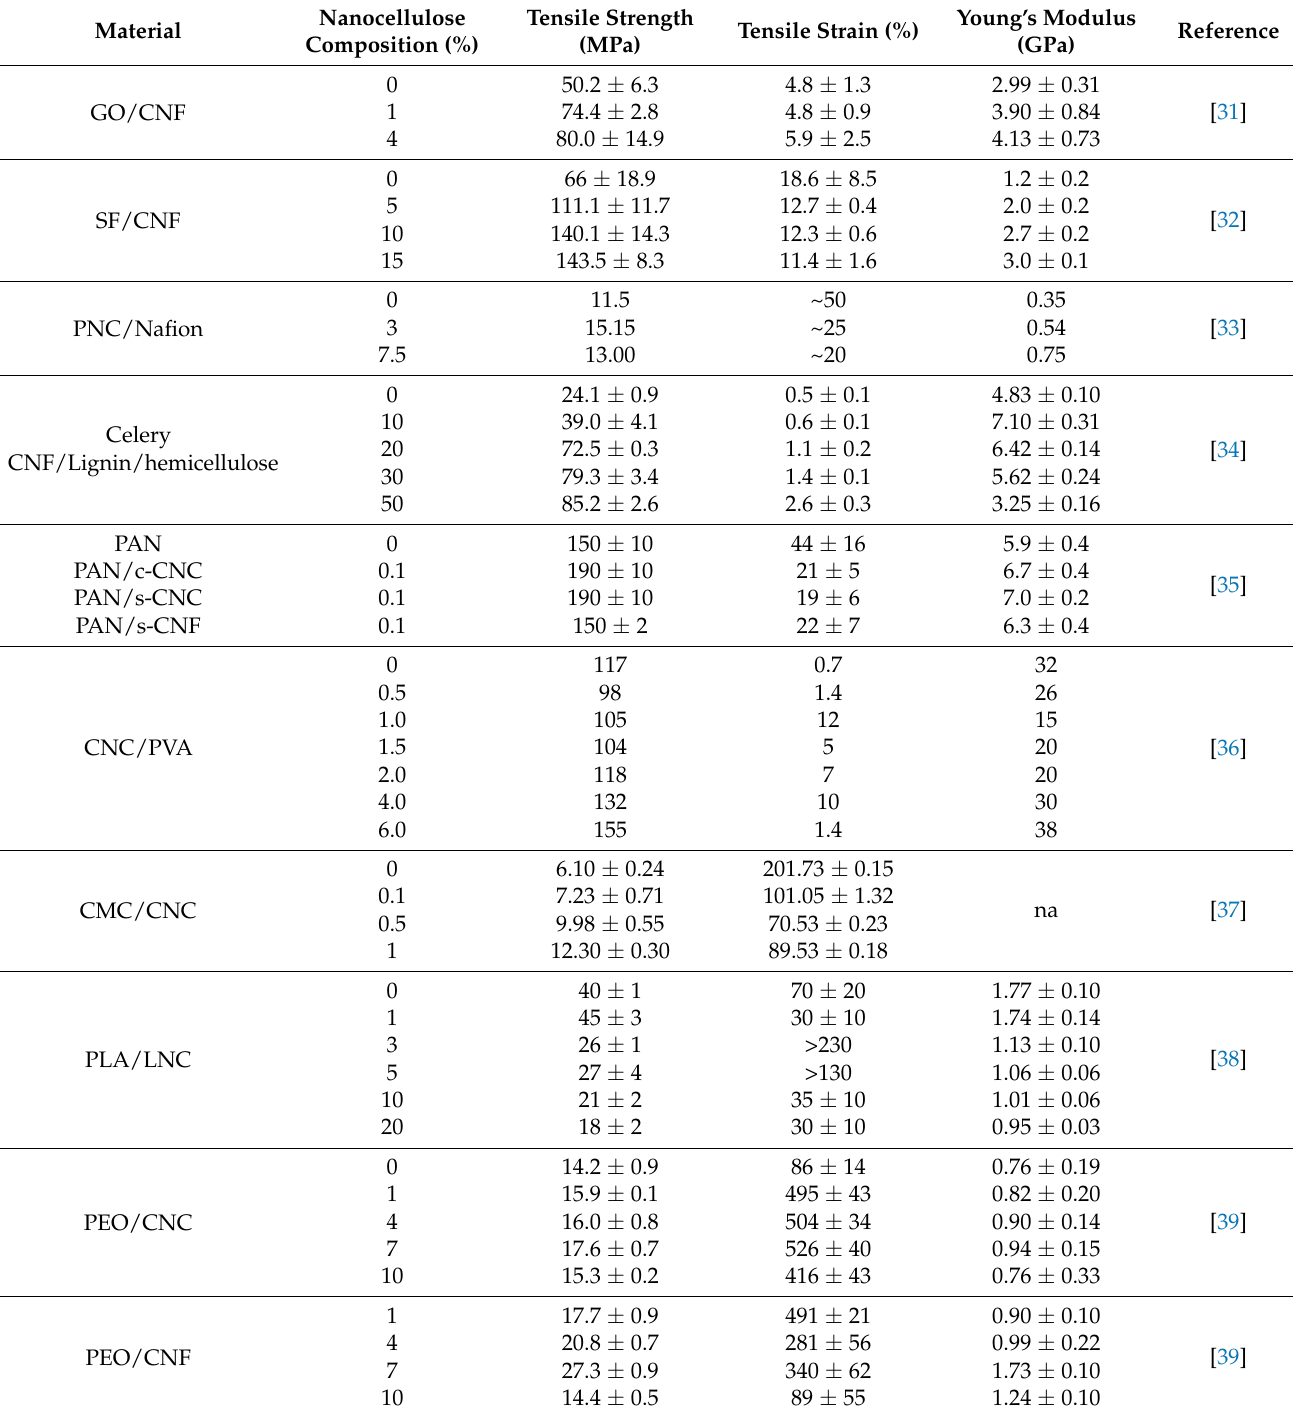
Table 2. Mechanical properties of nanocomposites reinforced with